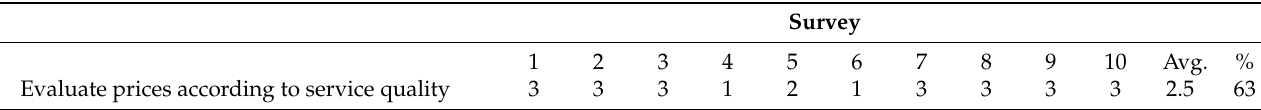
Table A5. Tourists’ price perception survey in Mazatlan [51,52].